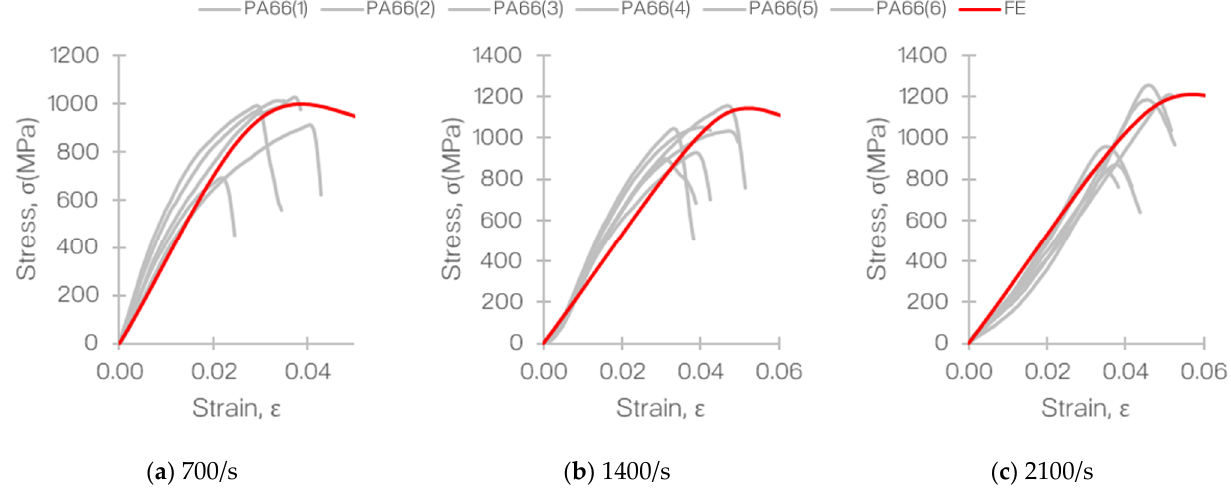
Figure 15. Comparison of stress-strain plots of T700/PA6.6 at different strain rates: ( a ) 700, ( b ) 1400, and ( c ) 2100/s obtained from the experiments and finite element analysis (FEA).